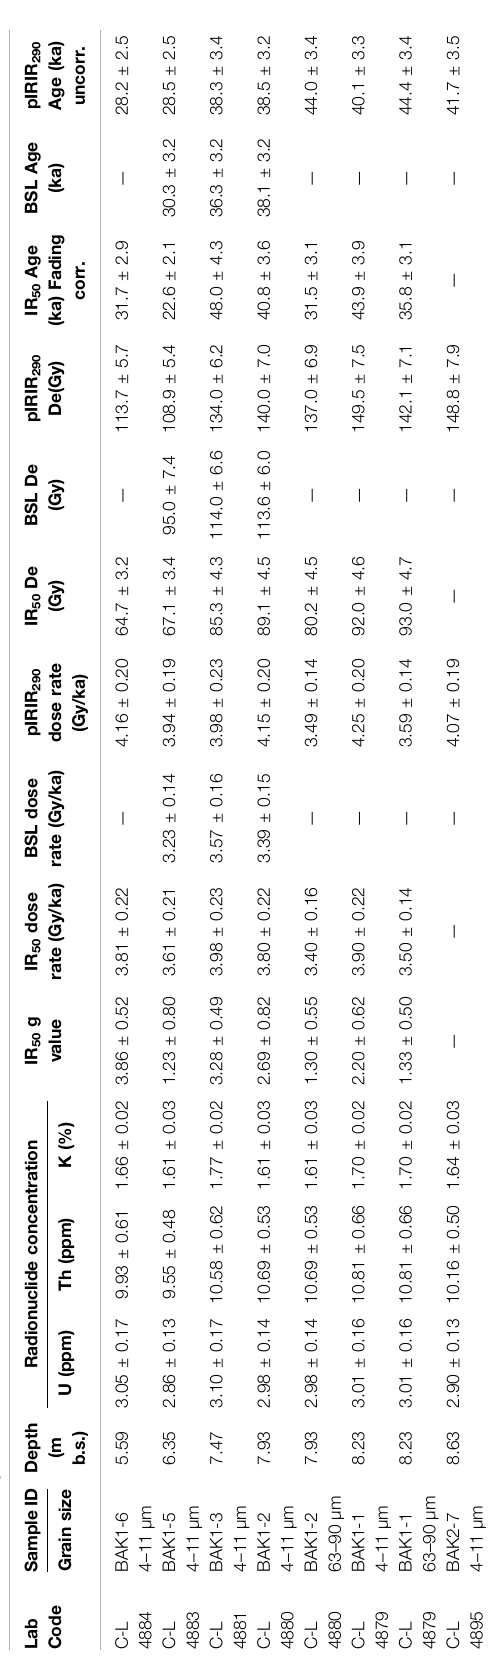
Supplementary Figure 1 . First IR stimulation temperature tests showed no dependency of the equivalent dose on the stimulation temperature, which indicates signal stability (Buylaert et al., 2012; Supplementary Figure 2B ). Dose recovery tests indicate that laboratory given doses were recovered within < 5% of unity for the IR 50 and pIRIR 290 signals of potassium feldspars and polymineral fi